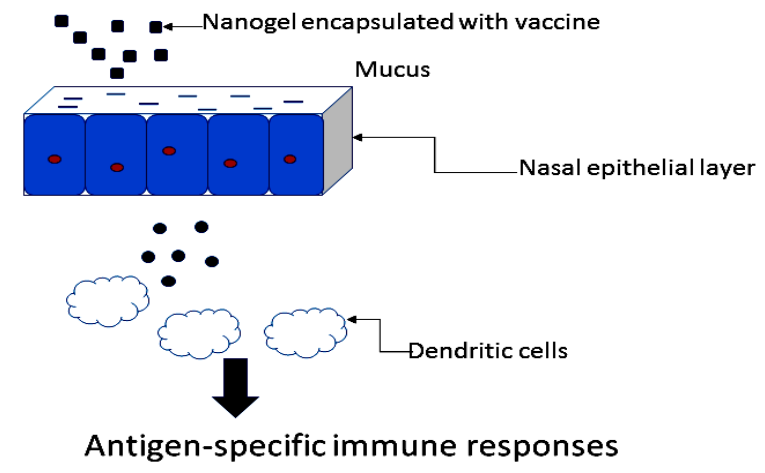
Figure 4. Nanogel as vaccine carriers.